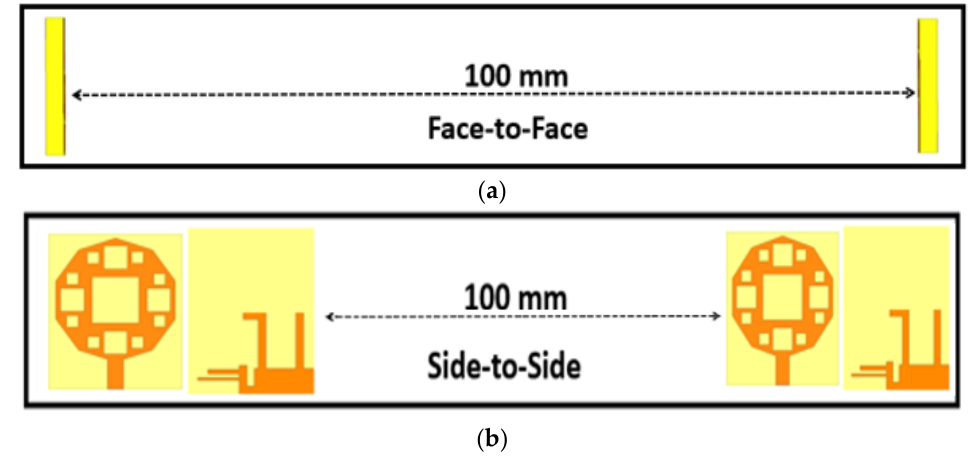
Phase response and group delay are performed by keeping a 100-mm gap between two antennas, as shown in Figure 37.